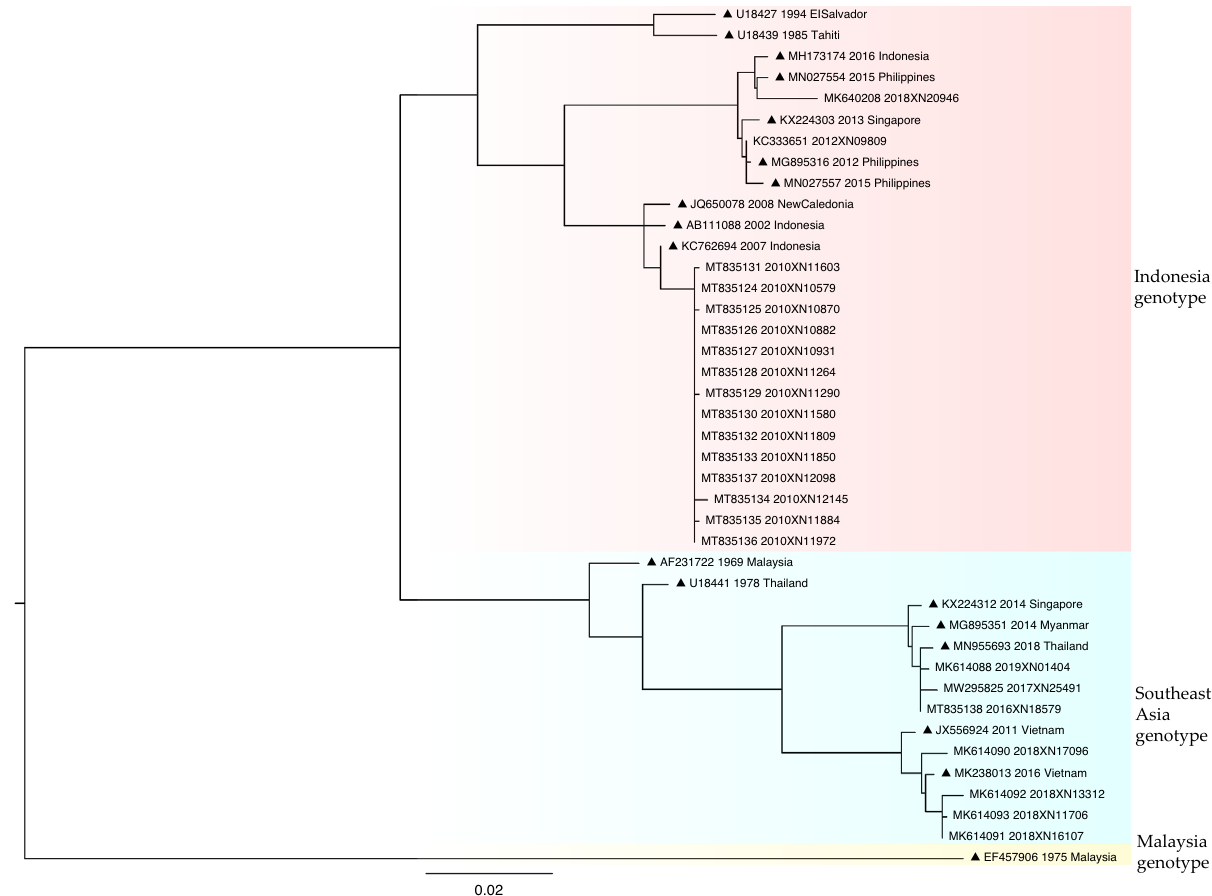
Figure 5. Phylogenetic tree of DENV4 E gene sequences. The reference sequences are indicated with black triangles for clarity, with the accession number, and year and country of isolation. Sequences detected in Guangzhou between 2010 and 2019 are indicated with the accession number, year of isolation, and the laboratory